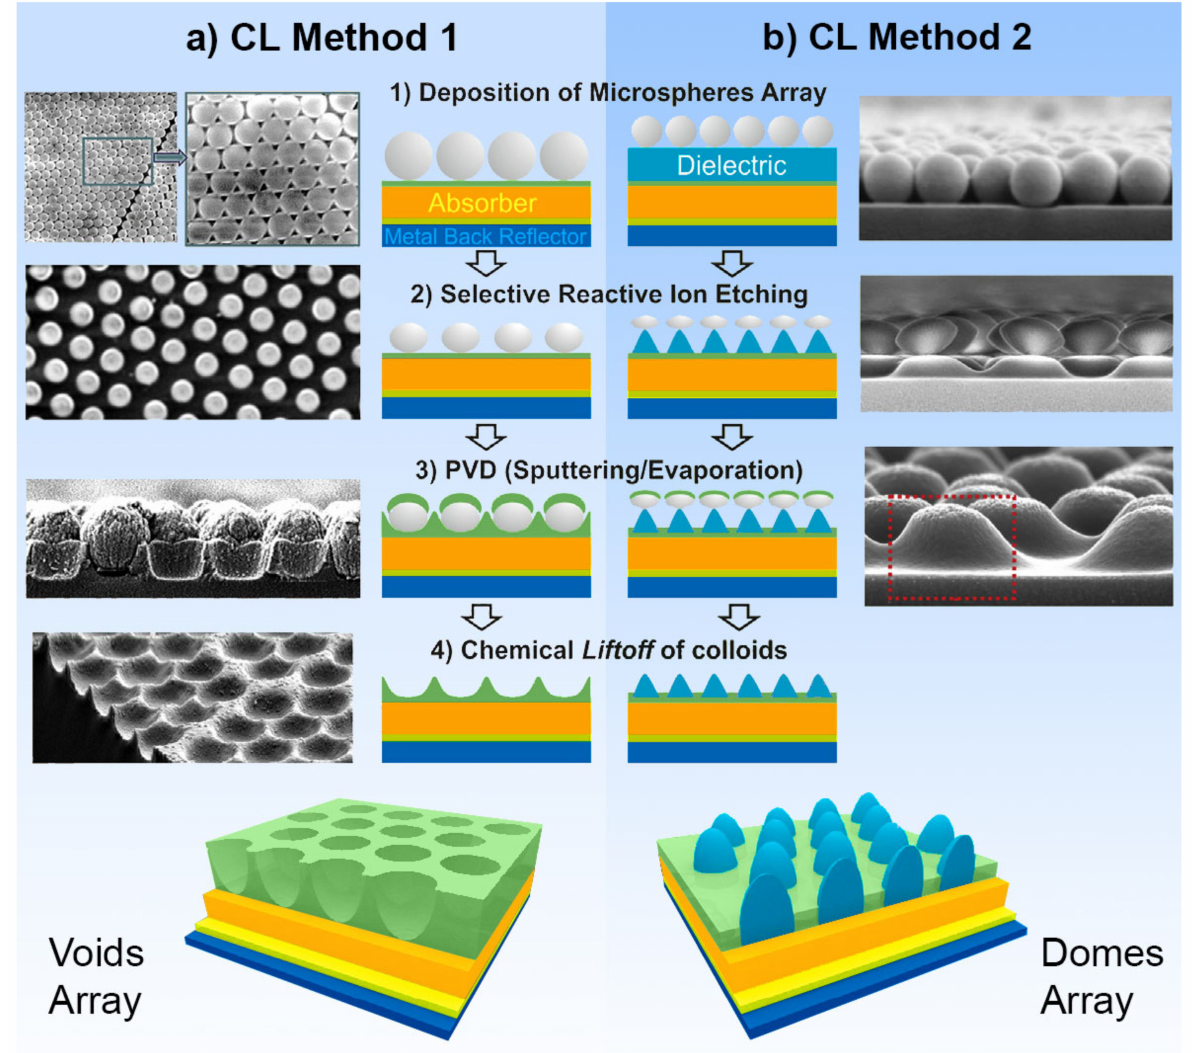
Figure 6. Depiction of two different CL methods used to create distinct geometries of photonic microstructures for light- trapping, integrated in the front contact of thin-film solar cells, arranged in non-closed-packed hexagonal (honeycomb) arrays of semi-spheroidal voids ( a ) or domes ( b ) Adapted with permission from [52]. Copyright 2021